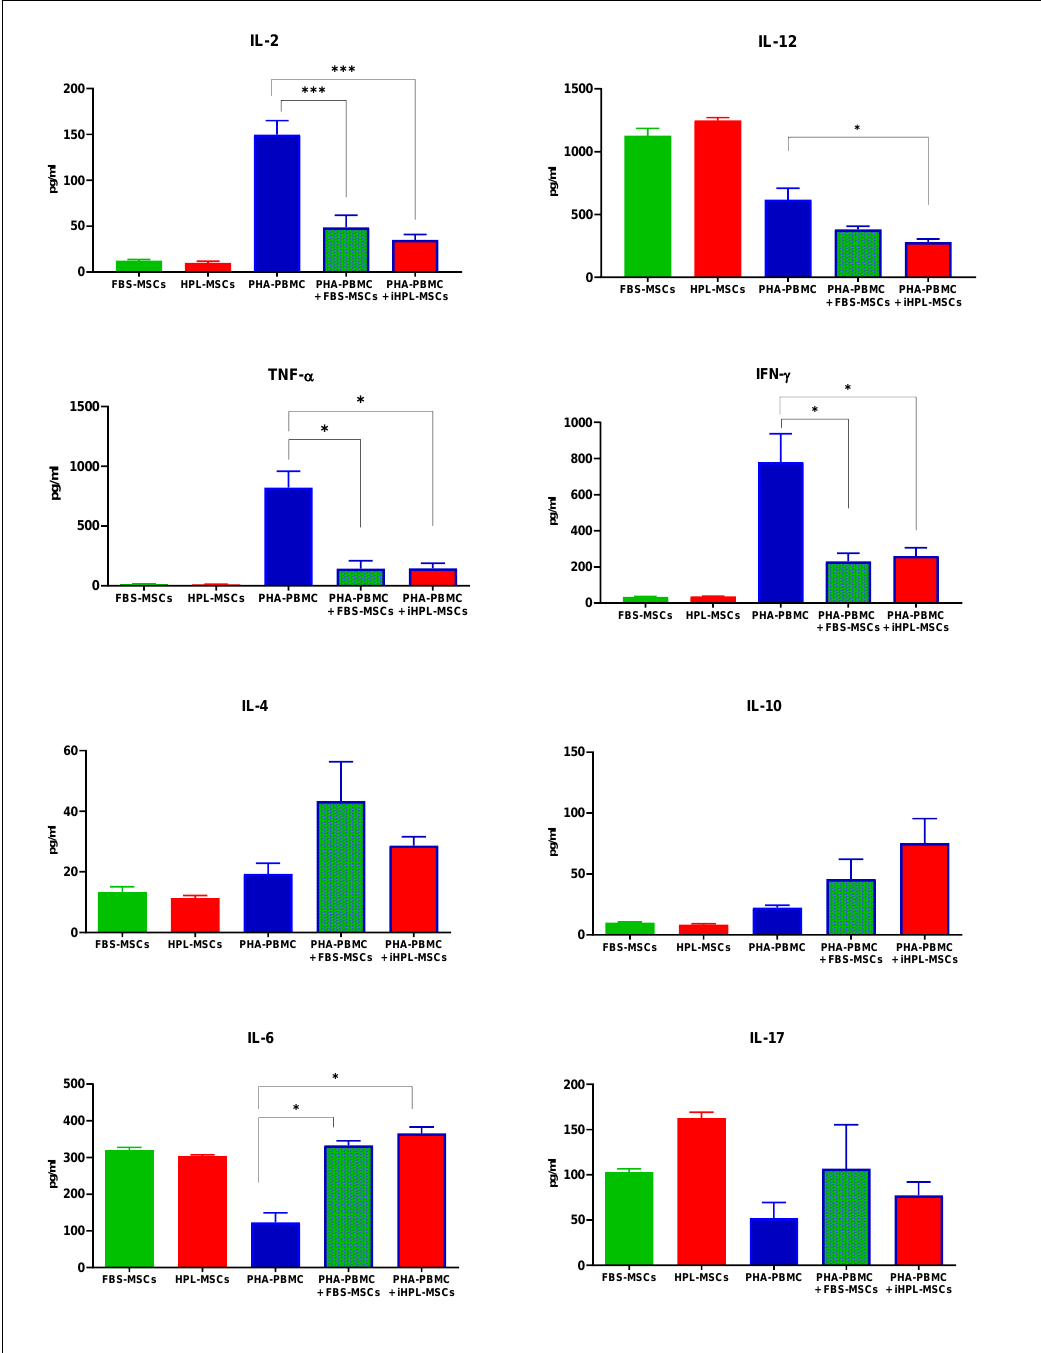
Figure 4. Th1 (IL-2, IL-12, TNF- α , and IFN- γ ), Th2 (IL-4 and IL-10), and Th17 (IL-6 and IL-17) cytokine release (pg / ml) analysed using ELISA assay in FBS-MSCs, HPL-MSCs, and PHA-PBMC in isolation, and in the co-cultures PHA-PBMC with FBS-MSCs or with iHPL-MSCs, expresses with mean values ± SEM ( n = 3). The symbols * and *** indicate statistically significant di ff erences with p < 0.05 and p < 0.001,